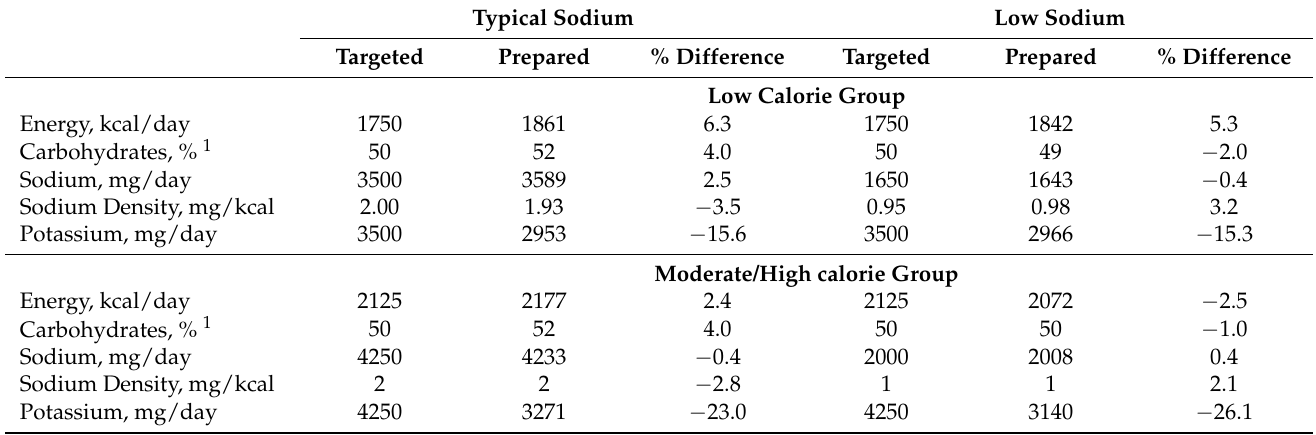
Table 3. The targeted and the prepared nutrient values by meal plan and calorie group.